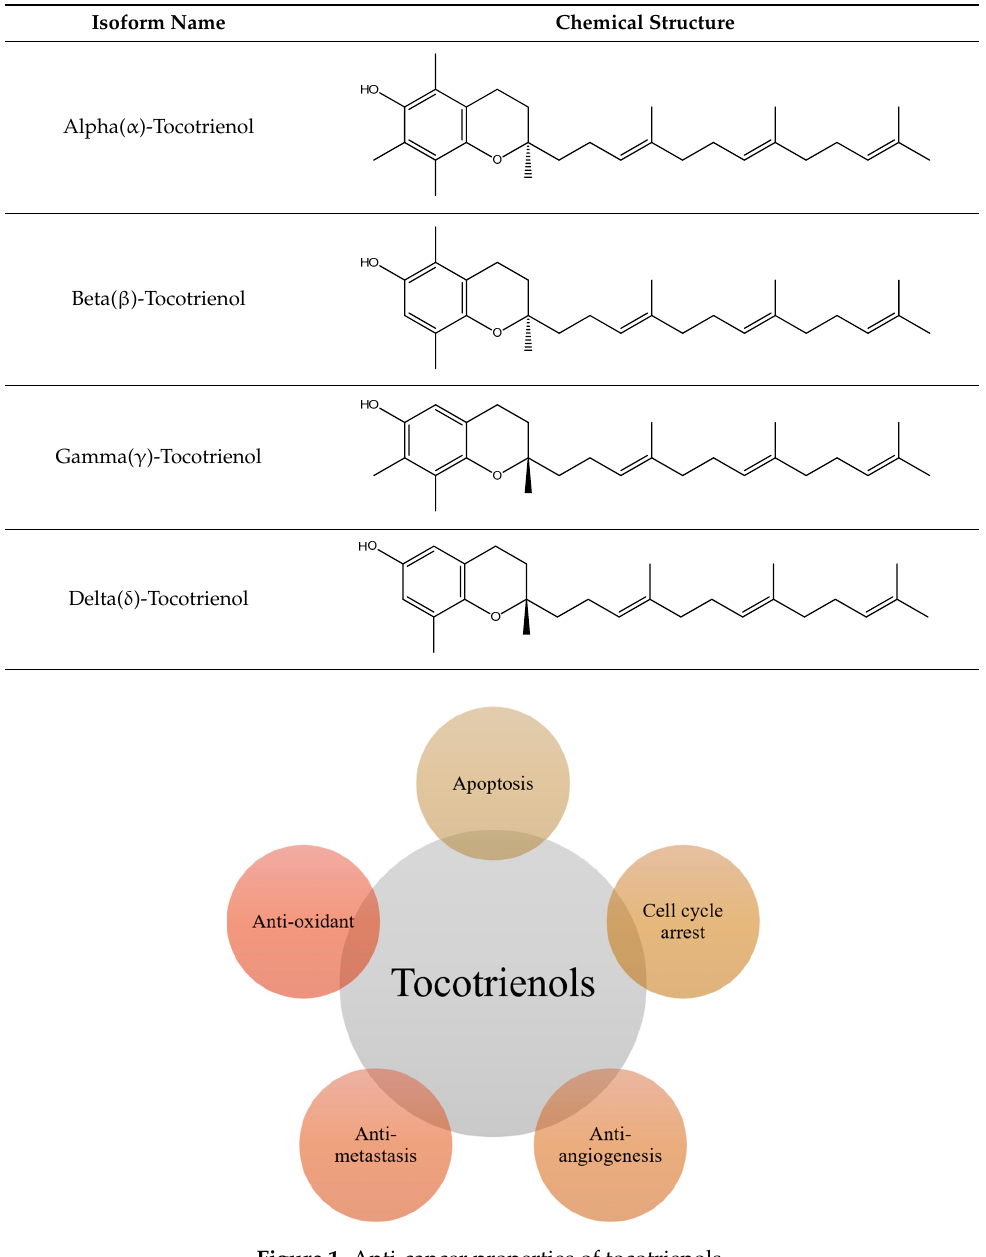
Figure 1. Anti-cancer properties of tocotrienols